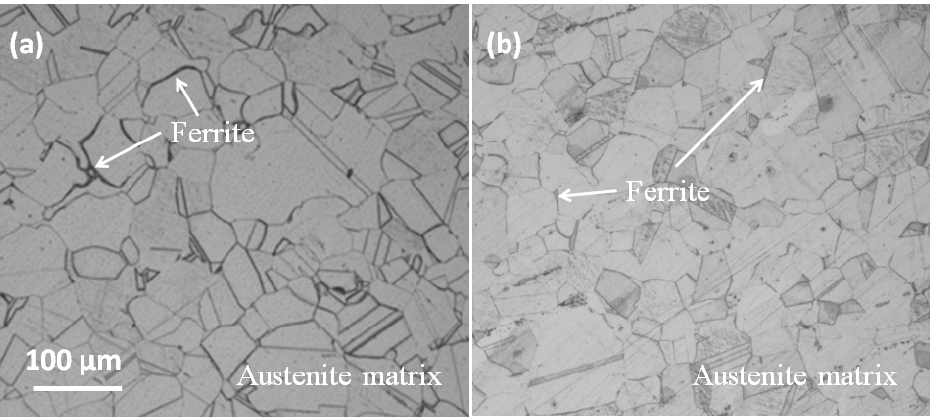
Figure 2. Microstructures of 316L ( a ) bonded with carbon steel and ( b ) without bonding.